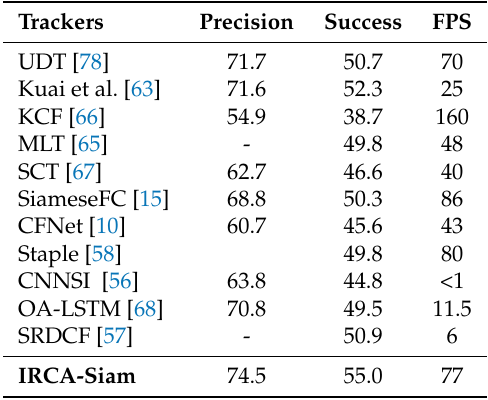
Figure 6. Qualitative analysis over CarScale , FaceOcc1 , Skiing , and Jogging-1 sequences. Table 2. Comparison of the proposed method with various state-of-the-art methods over TC128 using precision, success and speed in